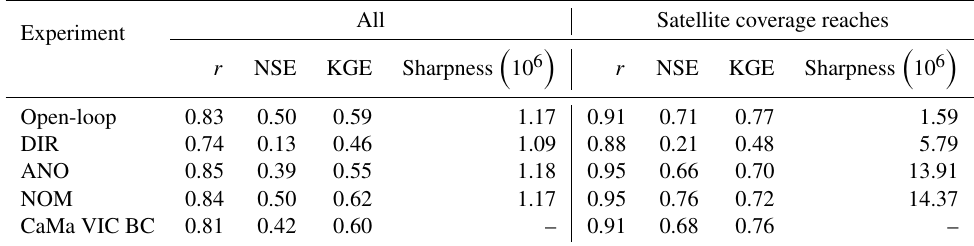
Figure 8. Performance of daily discharge in terms of the correlation coefficient (r) , Nash–Sutcliffe efficiency ( NSE ) , and Kling–Gupta efficiency ( KGE ) for (a) DIR, (b) ANO, and (c) NOM. Diamonds and circles indicate the gauges outside and inside the satellite altimetry coverage, respectively. Table 3. Median performance metrics for daily discharge estimates obtained from DA experiments. Median values for the correlation coef- ficient (r) , Nash–Sutcliffe efficiency ( NSE ) , Kling–Gupta efficiency ( KGE ) , and width of the confidence interval ( Sharpness ) are presented for all GRDC gauges and for gauges in the satellite coverage